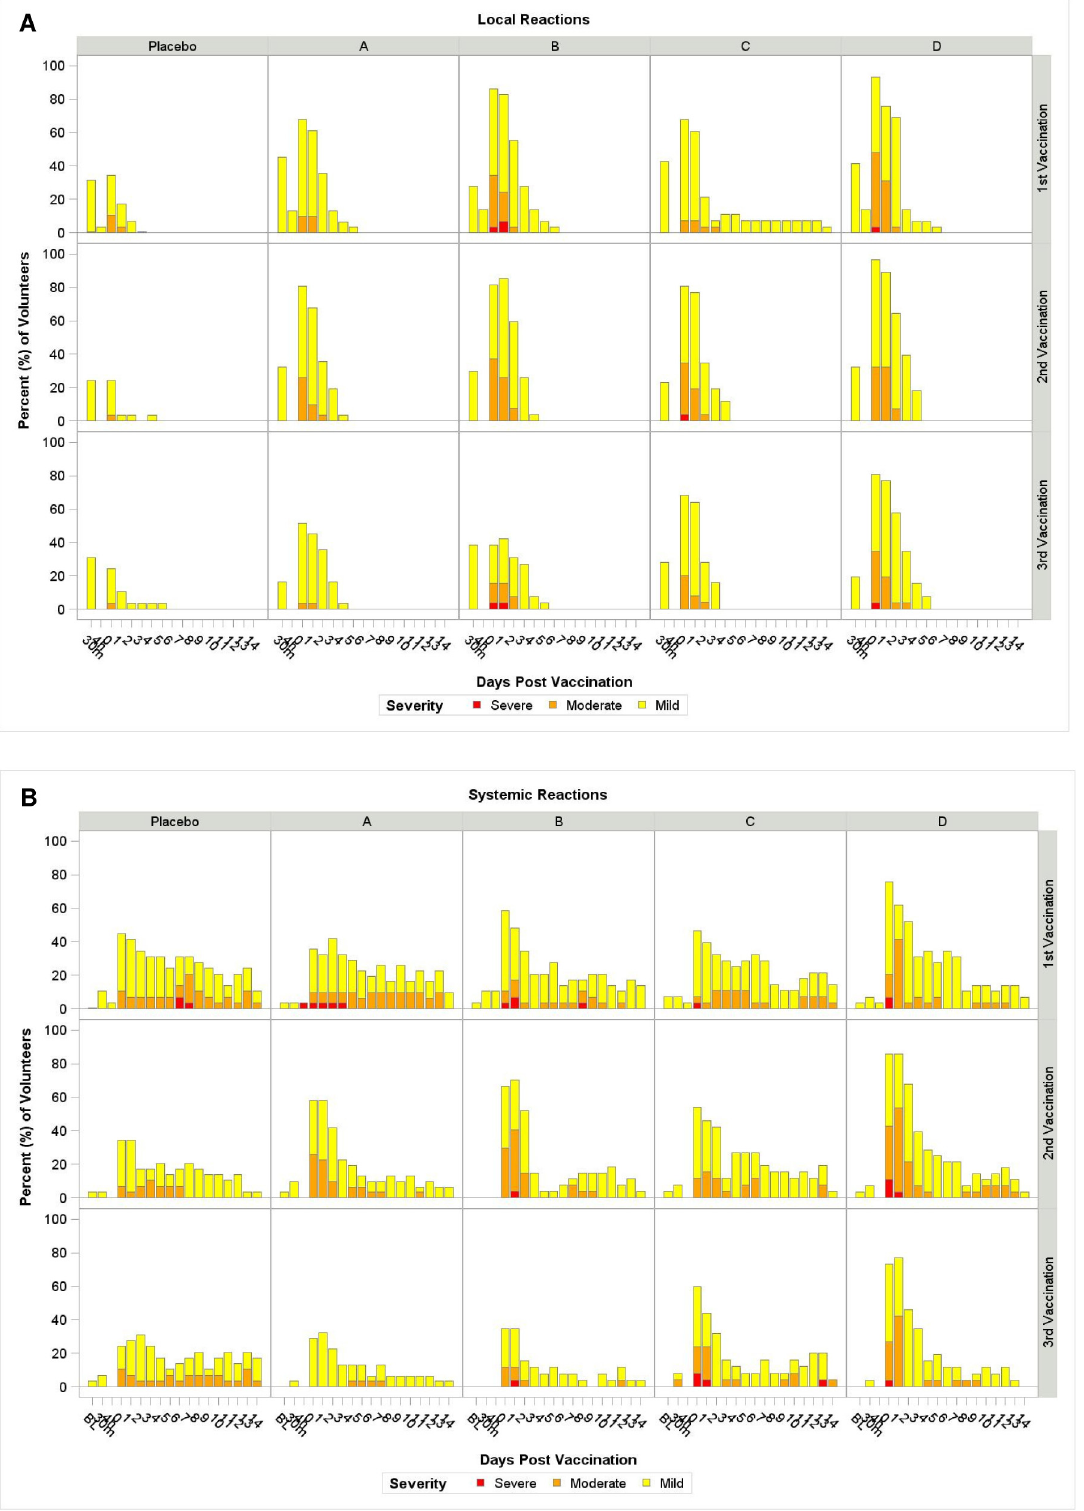
Fig 3. Time Course of Local and Systemic Reactions by group. The Y-axis represents the percentage of volunteers experiencing reactogenicity events. Panel A for local reactions and panel B for systemic reactions post first, second and third vaccinations with upper, middle and lower rows respectively for